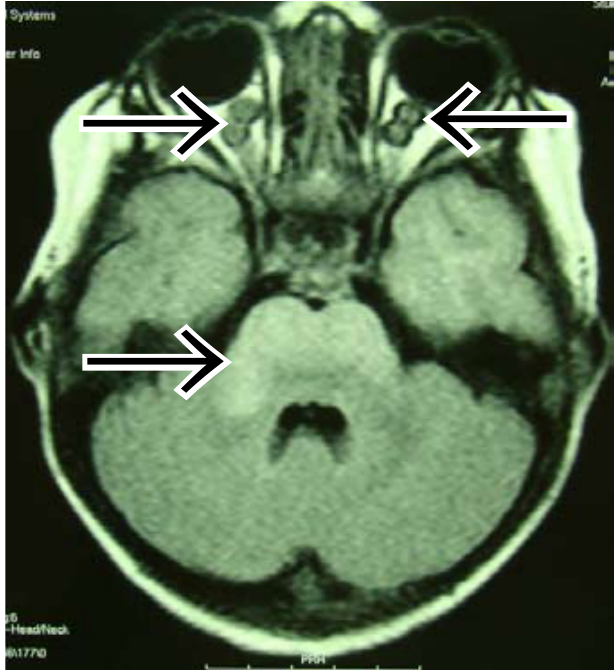
Fig. 6d. Axial FLAIR MRI sequence demonstrating bilateral optic nerve gliomas and FASI changes in the brainstem.